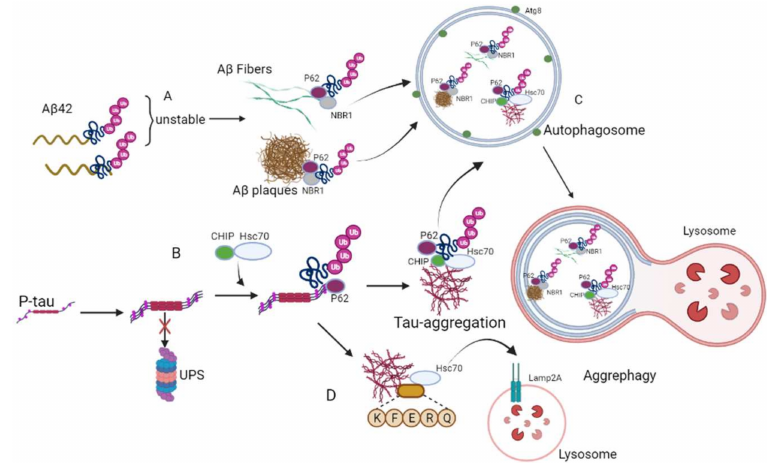
Figure 1. Mechanism of aggrephagy during the occurrence of AD. ( A ) Polyubiquitinated A β plaques and fibers binds to p62 and NBR1 specifically, and initiate degradation through aggrephagy. ( B ) Hsc70 interacts with CHIP to regulate tau ubiquitination and then is recruited by p62. ( C ) All these aggregate proteins are wrapped by autophagosomes for degradation. ( D ) KFERQ binds with tau aggregates and is transferred to the lysosome by the Lamp2A receptor for